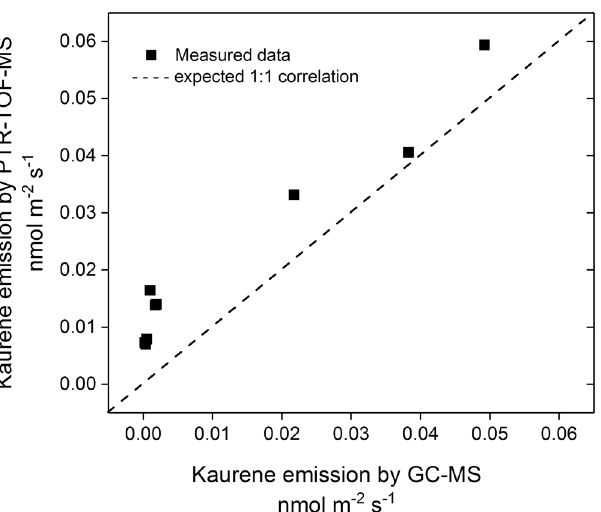
Figure 7. Relationship between PTR-TOF-MS and TD-GC-MS data. A 1:1 line is plotted for